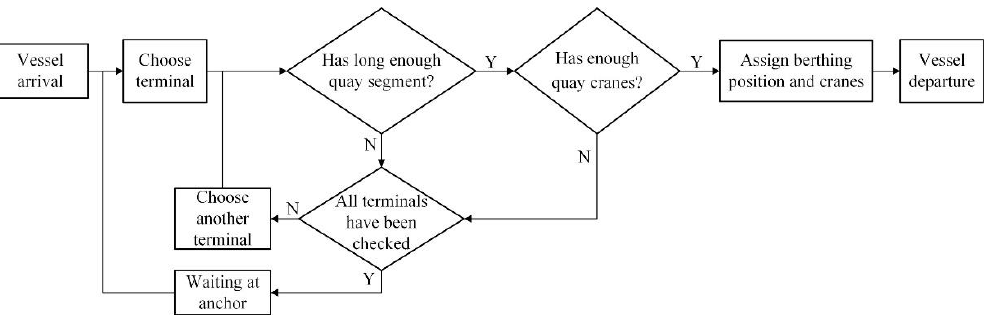
Figure 5. The scheduling process of vessels in a port with multiple terminals. (Source: compiled by the authors).